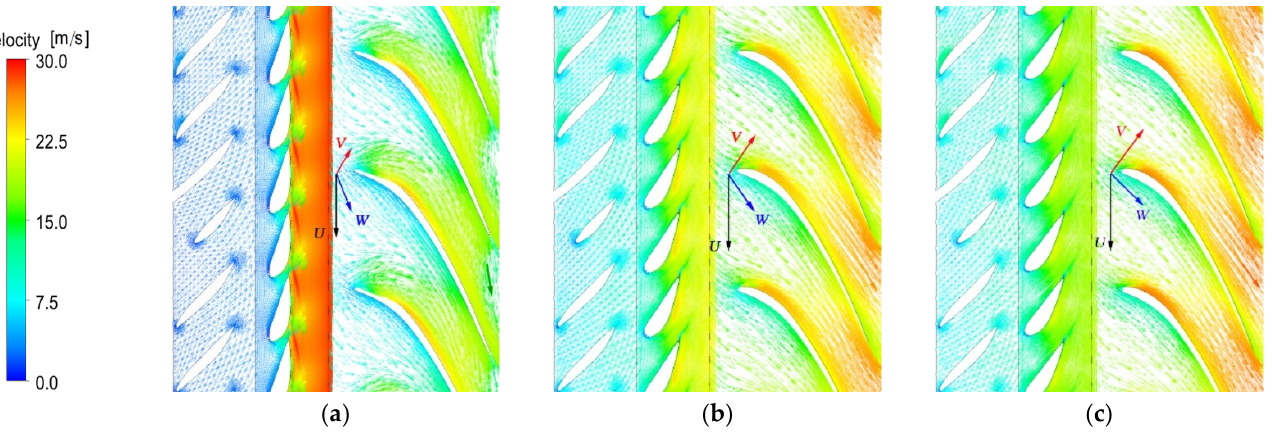
Figure 3. Velocity vector at the rated head. ( a ) OP1, ( b ) OP2, and ( c ) OP3. The velocity vectors in the flow components at the maximum head are shown in Figure 4. The head increased and the velocity around the airfoil increased in the runner region due to the change in inflow conditions. The turbulence characteristics of the three GVOs were similar to those of the rated head. Based on the velocity triangle at the runner inlet, the circumferential velocity is a fixed value, the absolute velocity increases at the inlet, the absolute flow angle is related to the GVO, and the relative velocity angle increases, reducing the impact loss at the blade inlet.